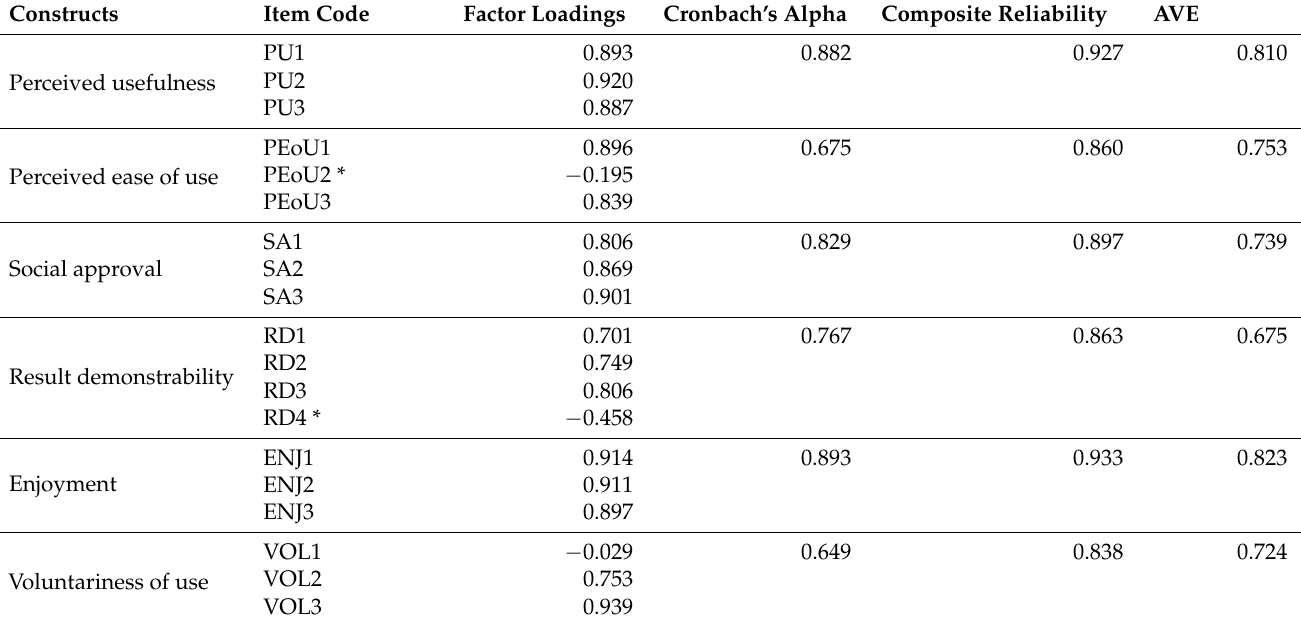
Table 3. Reliability and validities of